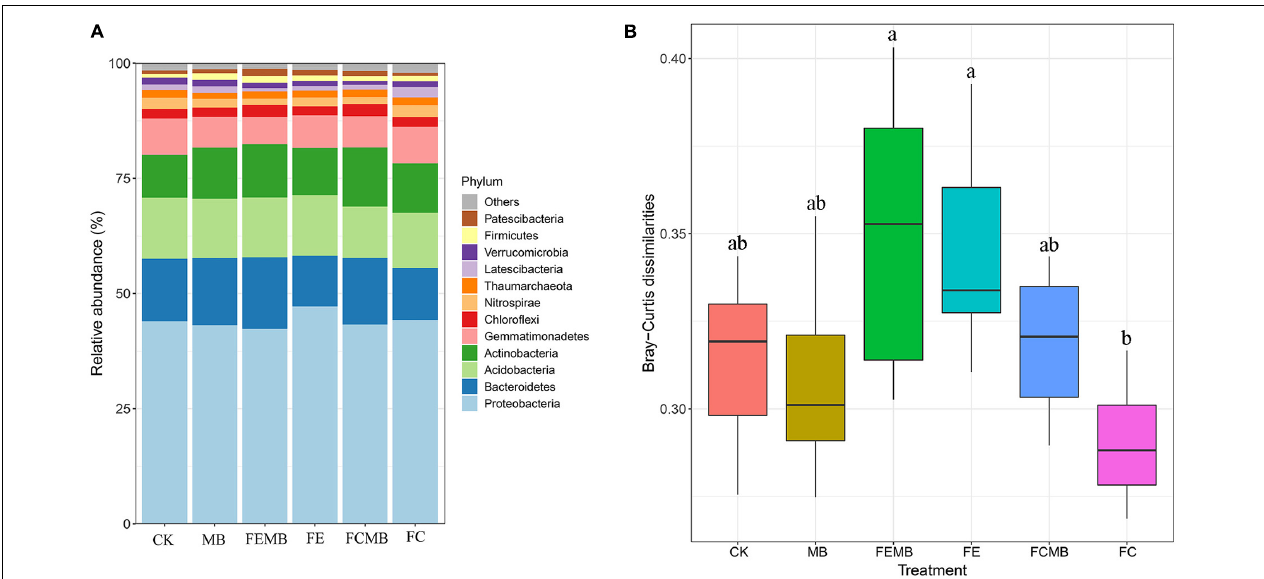
FIGURE 1 | Bacterial community composition in the field grown with Houttuynia cordata under different fertilization regimens. (A) Relative abundance heatmap of the top 12 phyla. (B) Dissimilarity distance of the bacterial community structures; different lowercase letters indicate significant differences ( p < 0.05).